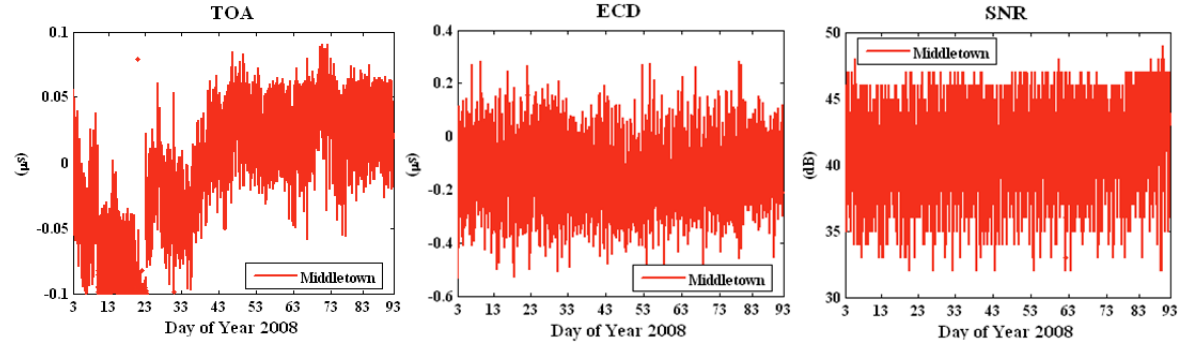
Figure 2. Stanford seasonal monitor data for 90-day period for Middletown, CA: (a) TOA; (b) ECD; (c)